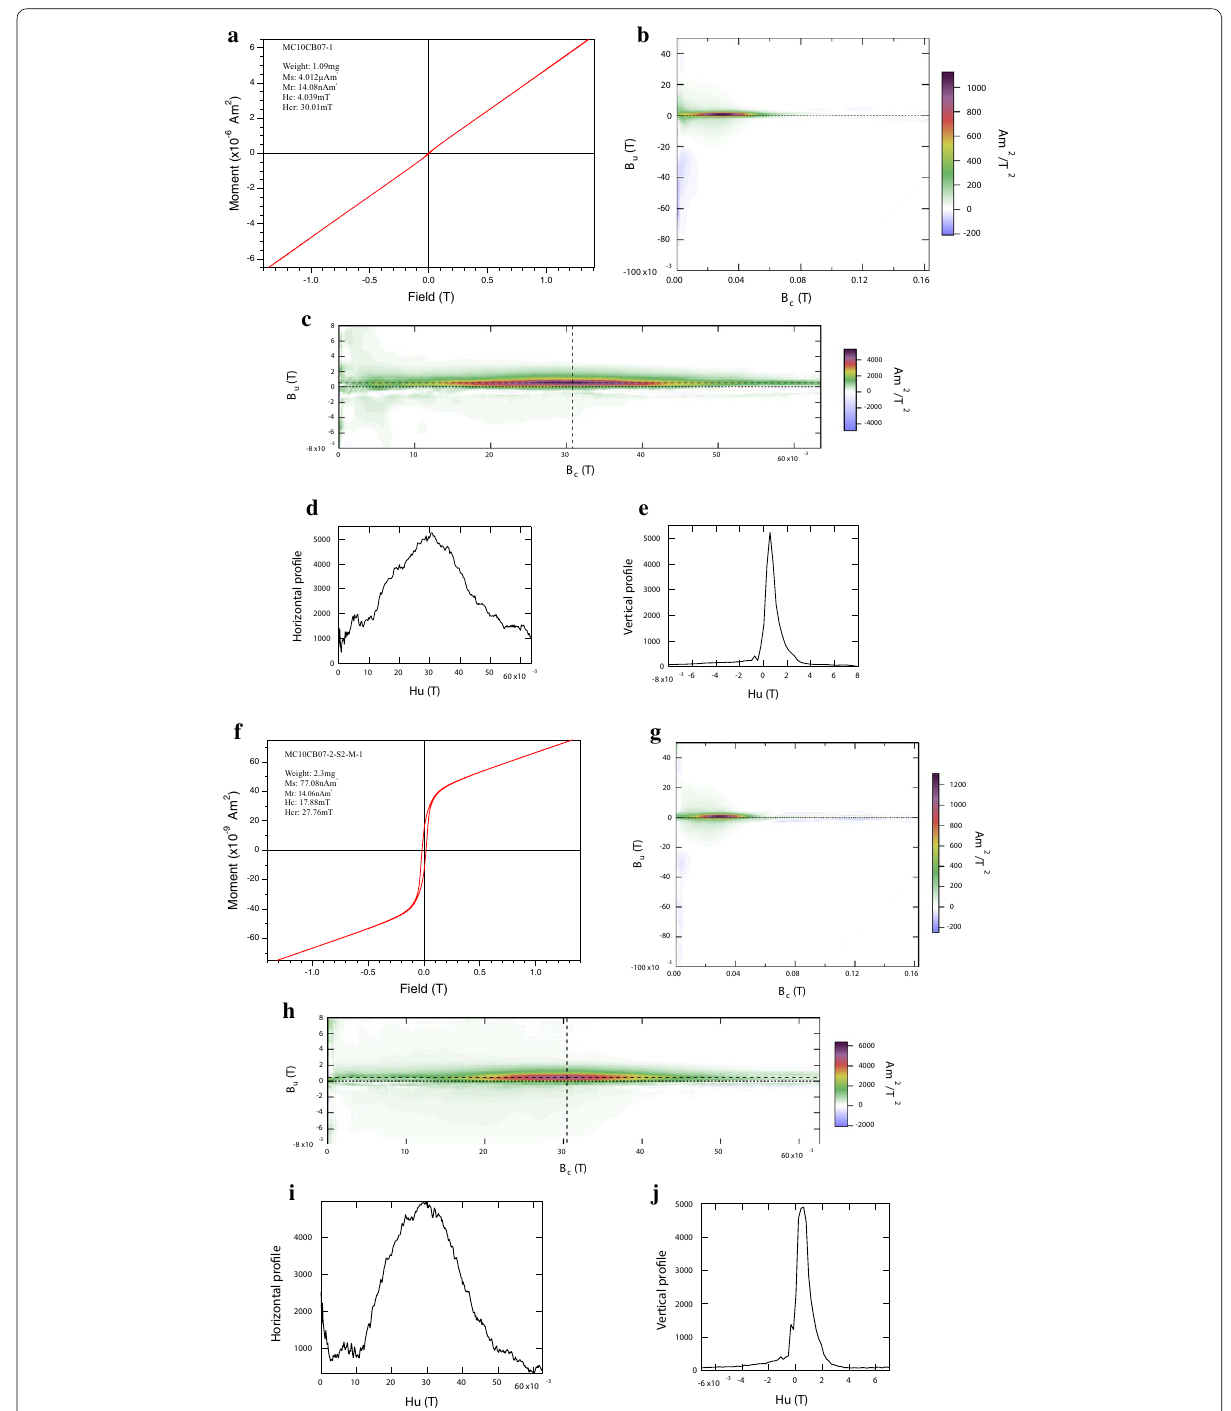
Fig. 5 a Hysteresis loops and parameters for a bulk sample (10.9 mg) taken at 0–10 mm from the surface. b FORC diagram for the same sample (Bu 40 mT ~ 40 mT, Bc 0 ~ 150 mT, average time 100 ms). c A closed-up of FORC diagram along the central ridge (Bu = − + = = Bc 0 ~ 60 mT, average time 100 ms) and cross sections d along horizontal line at Bu = = loops and parameters for the residue after chemical leaching and magnetic extraction (2.3 mg) for a sample taken at 0–10 mm from the surface. g FORC diagram for the same sample (Bu 40 mT ~ 40 mT, Bc 0 ~ 150 mT, averaging time = − + = central ridge (Bu 5 ~ 5 mT, Bc 0 ~ 60 mT, average time 200 ms) and cross sections i along horizontal line at Bu = − + = = line at Bu 33 =